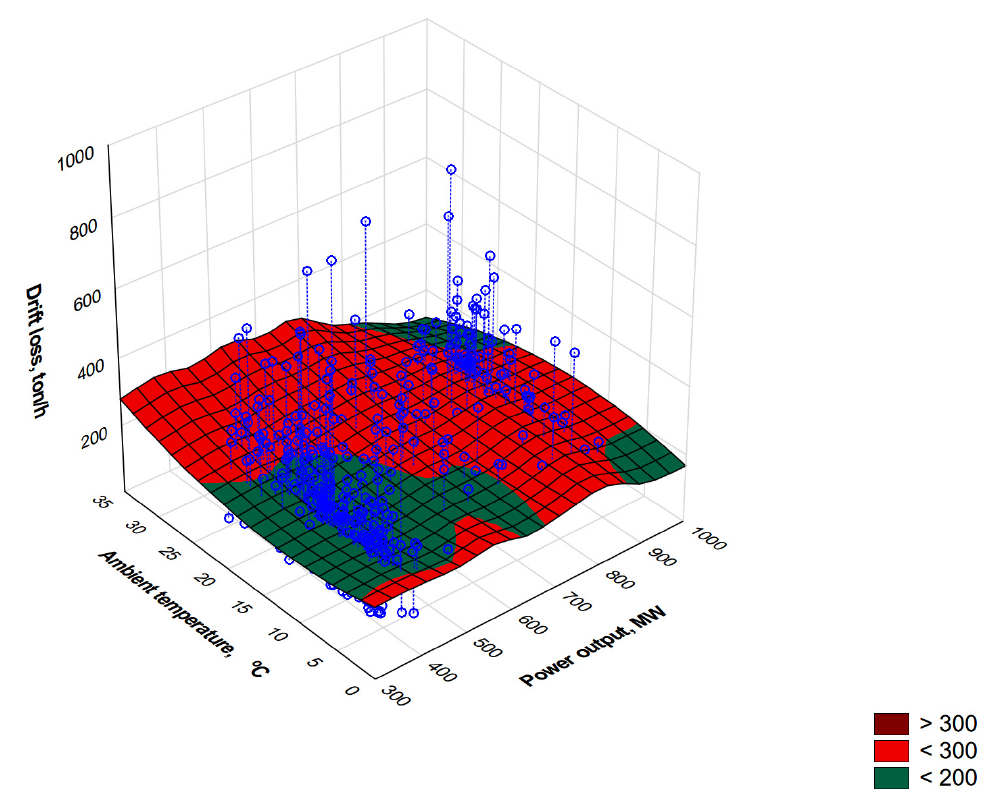
Figure 6. Effect of unit power and ambient temperature on the sum of evaporative and drift losses.